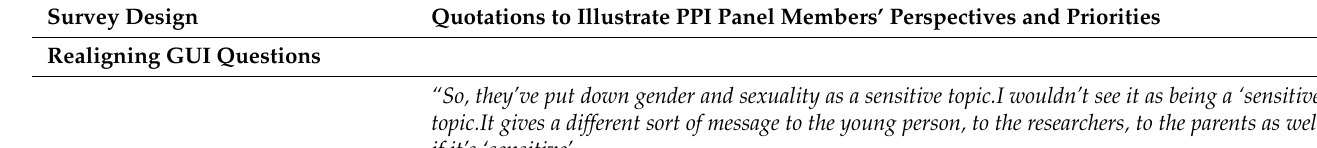
Table 3. PPI Panel members’ reflections on research validity and SOGI survey